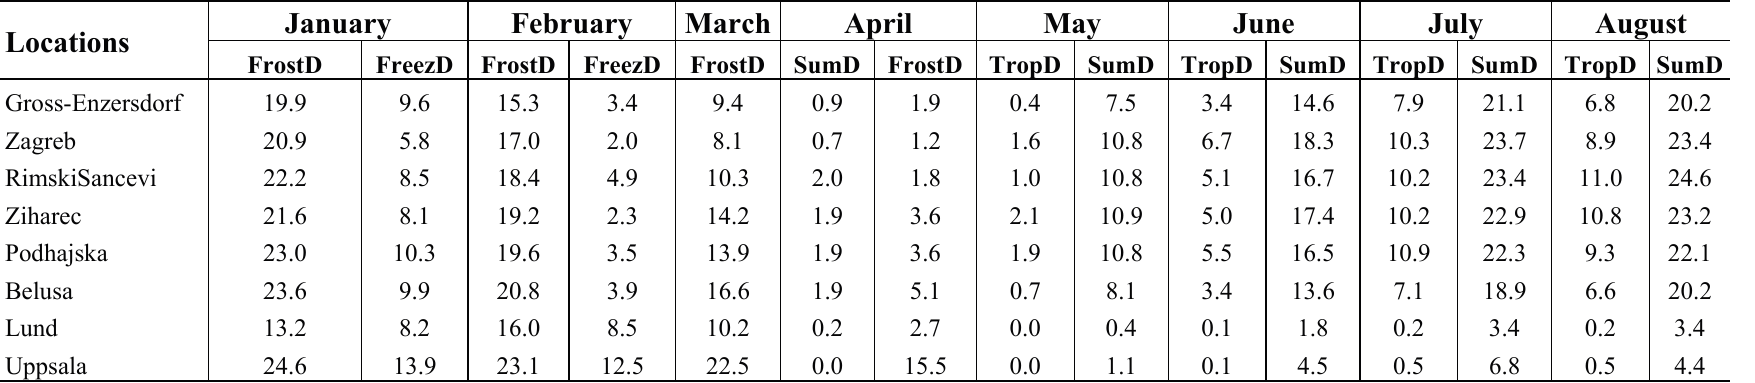
Table 3. Average number of days with extreme temperatures at the selected locations for the periods shown in Table 1.